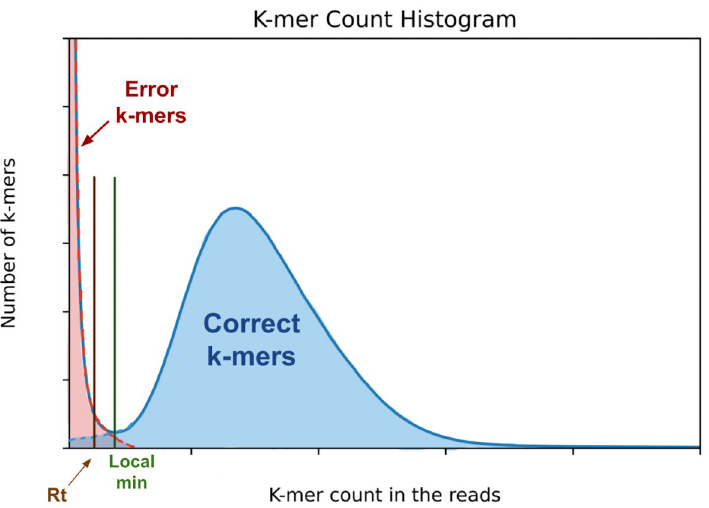
Fig 1. A typical k-mer count histogram for low-error-rate sequencing data (Illumina or PacBio HiFi). The red region contains error k-mers that are due to sequencing errors in the reads. The blue region represents the distribution of the counts of correct k-mers in the reads. The x-position labeled R t is defined as half of the x coordinate of the local minimum of the distribution.